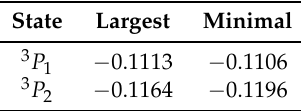
Table 8. The proportionality constant λ (in %fm − 2 ) for the states 3 P 1 and 3 P 2 with both the largest and minimal expansions.